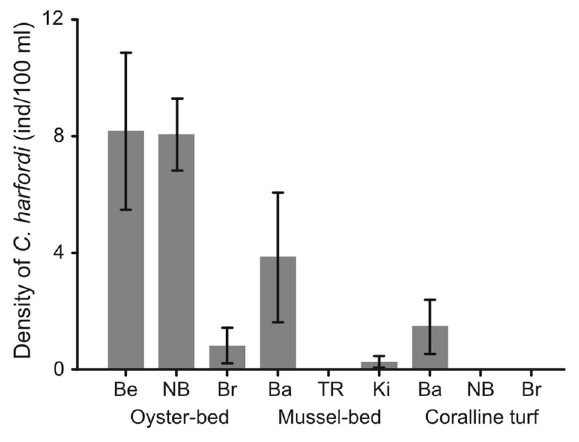
Figure 2. Habitat distribution and densities. Mean ( 6 S.E.) densities of Cirolana harfordi for oyster-beds, mussel-beds and coralline turfs at Berrys Bay (Be), Neutral Bay (NB), Bradley’s Head (Br), Balmain (Ba), The Rocks (TR) and Kirribilli (Ki) in June